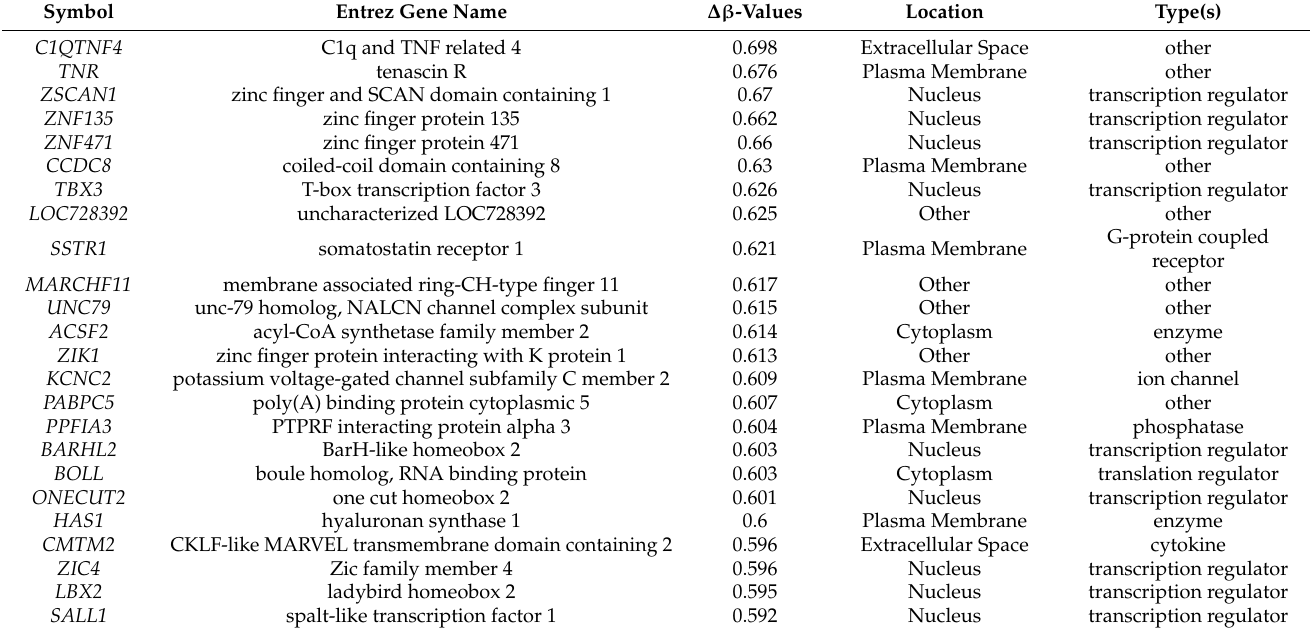
Figure 2. Unsupervised hierarchical clustering of the differentially methylated probes for VSCC and normal vulvar tissues, based on the differences in the β -values ( ∆ β -values–indicated in the scale). Green represents hypo-methylated, and red represents hyper-methylated probes. Table 2. Differentially methylated genes based on Δβ -values (top 25).